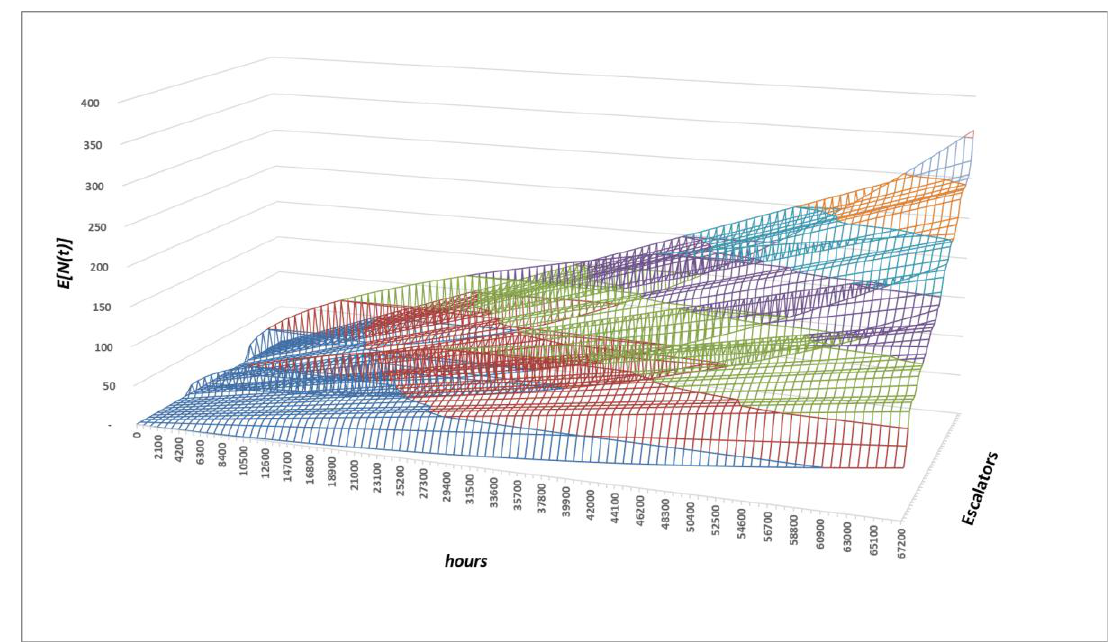
Figure 6. 3D graphic representation of the E[N(t)] models of the TNE